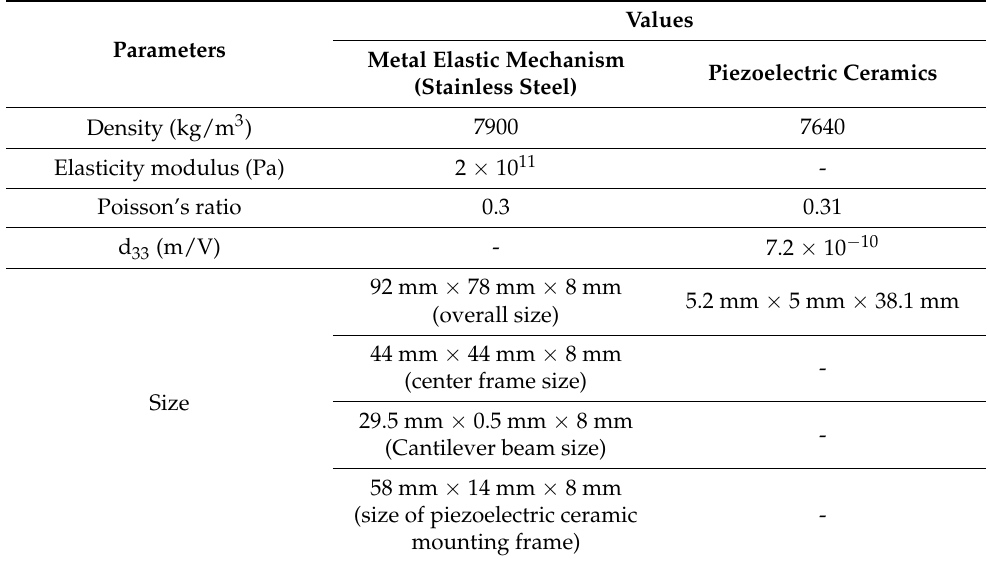
Table 1. The main materials and dimensions of the piezoelectric